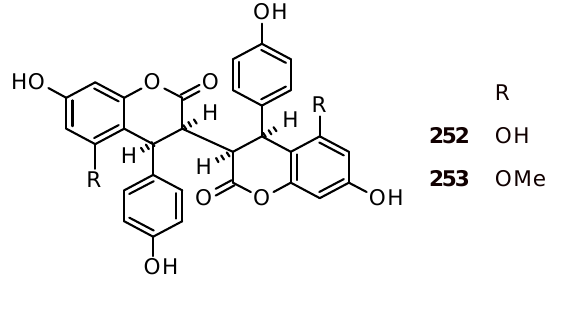
Figure 30. Structures of 4-aryl-3,4-dihydrocoumarin dimers 252 and 253